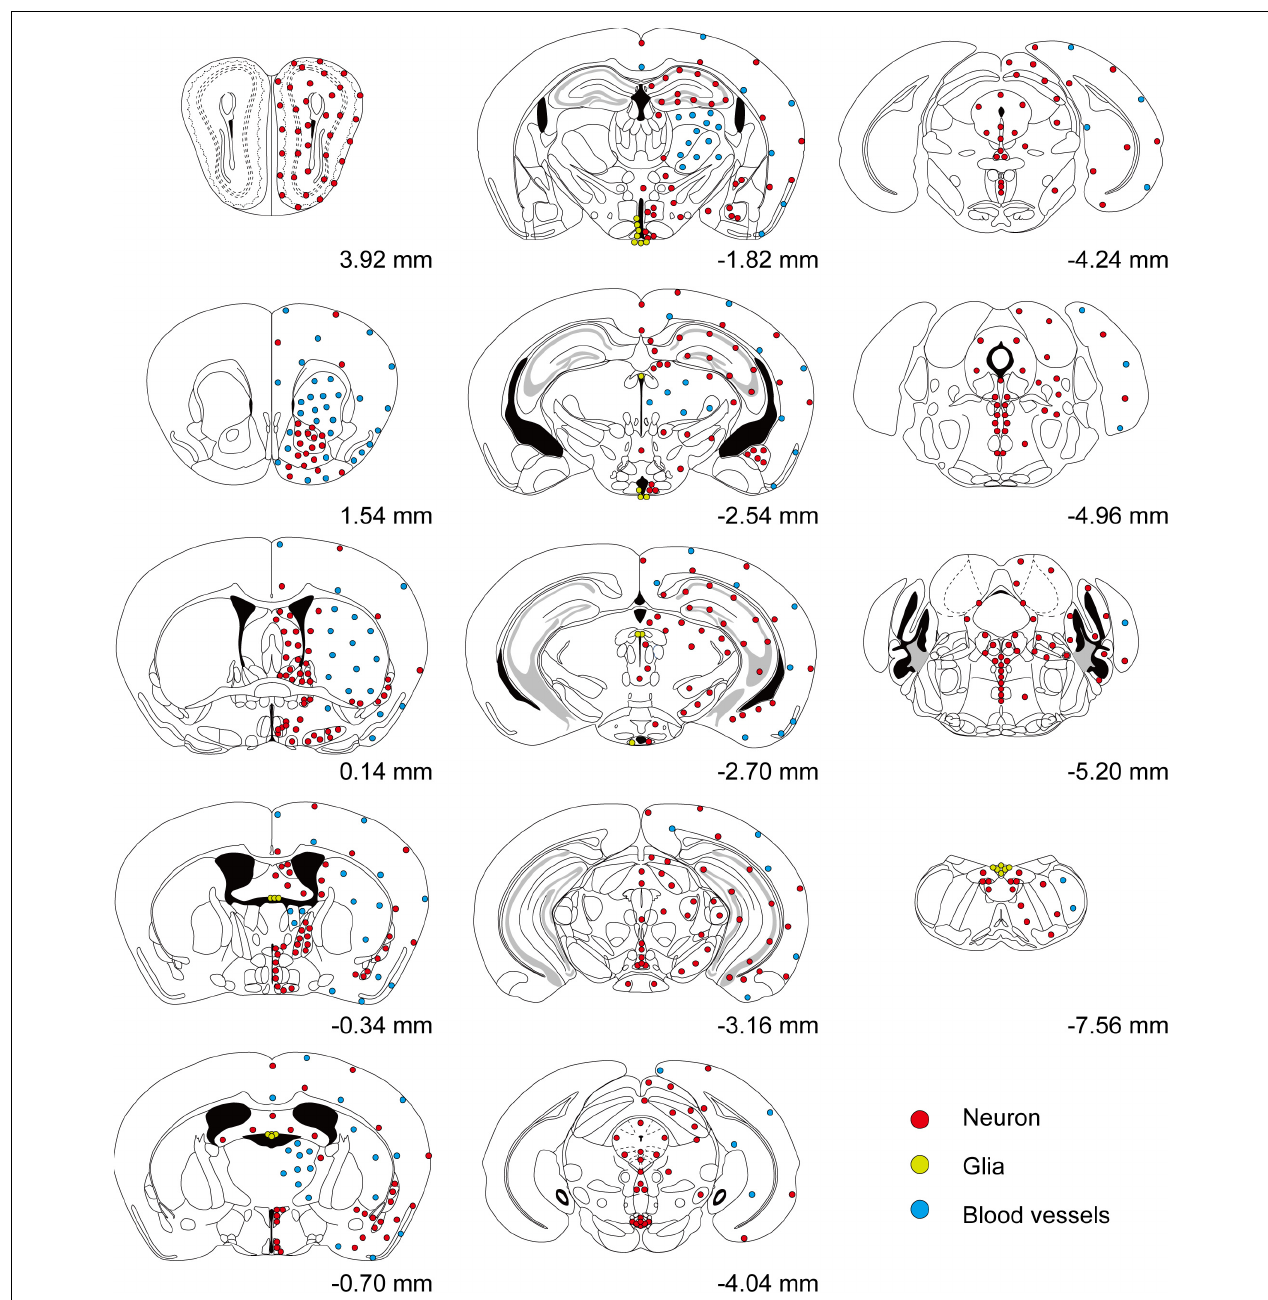
FIGURE 2 | Overall distribution of T1r2-Cre -labeled cells in the brain. Coronal section figures were modified from the Paxinos mouse brain atlas (third edition) and re-drawn. Relative positions compared to bregma are indicated. Red circles (neurons); yellow circles (astrocytes); and blue circles (blood